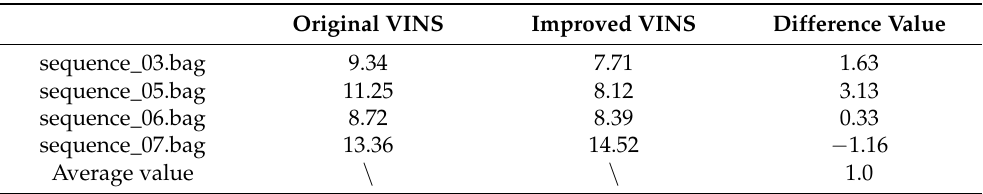
Table 16. The feature extraction speed of the original algorithm and the improved algorithm is compared in the underwater dataset (Unit: ms).